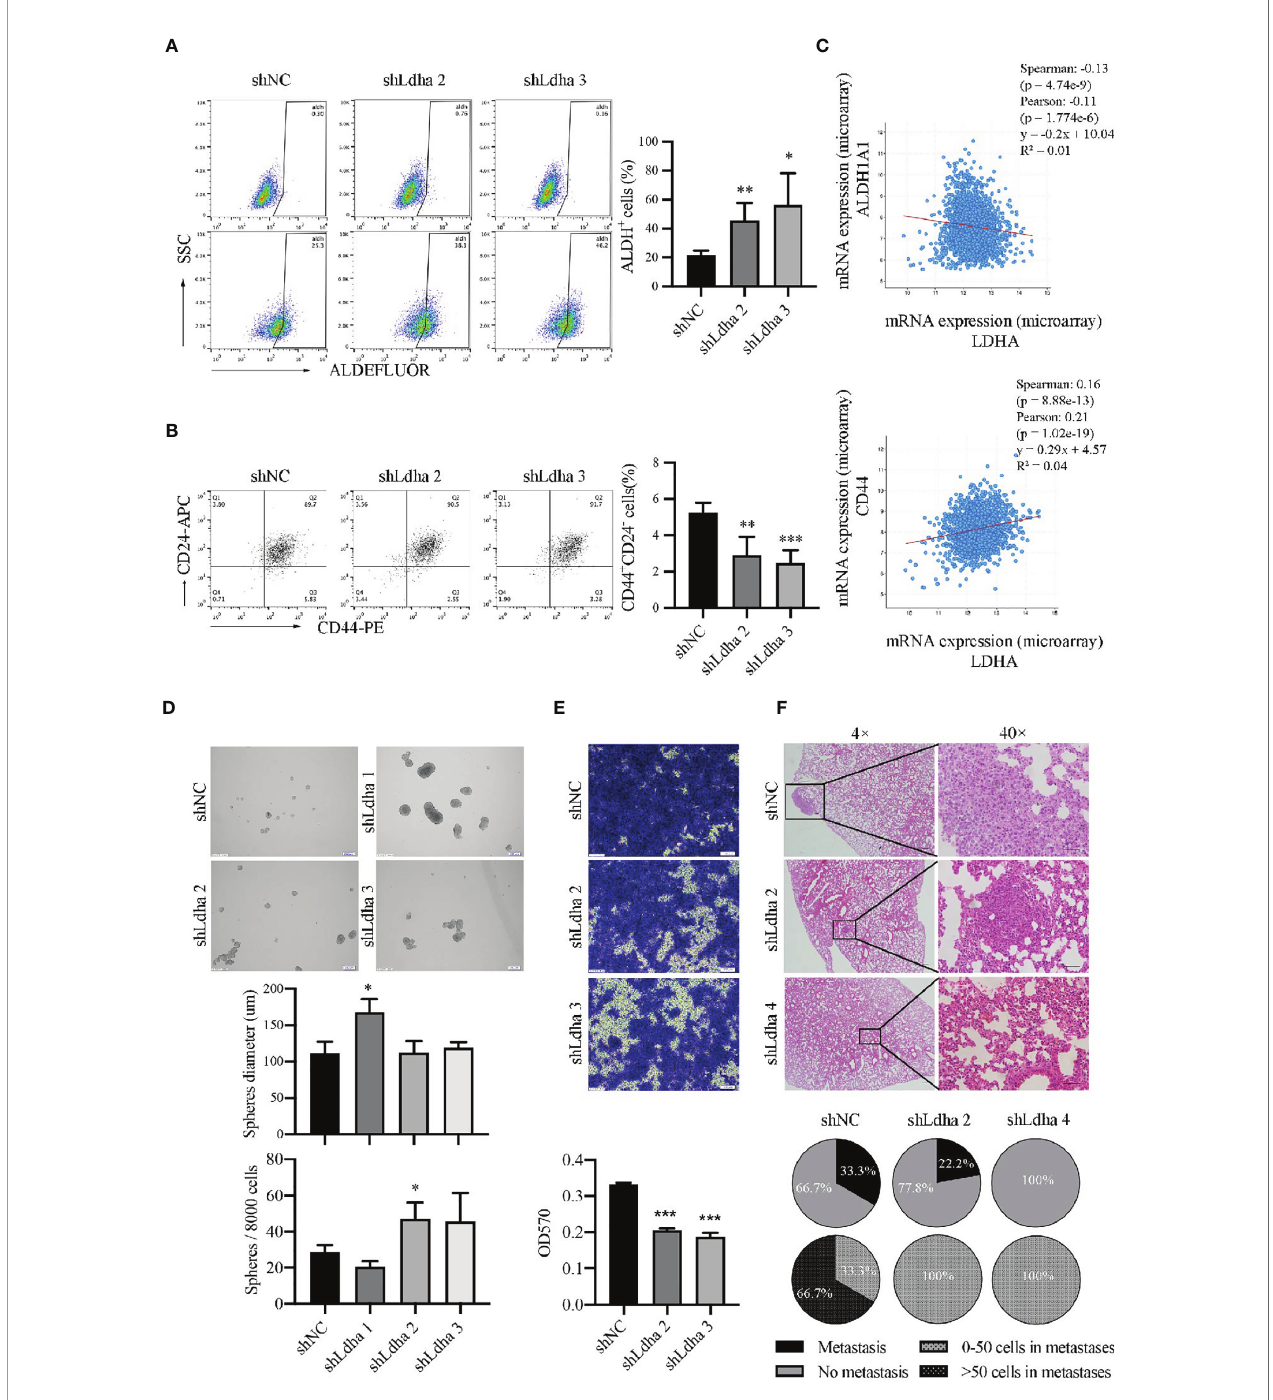
FIGURE 3 | LDHA promoted E to M transition of BCSCs in mouse 4T1 cancer cells. (A) Percentage of ALDH + cells in 4T1- shNC or 4T1-shLdha cells was analyzed by fl ow cytometry. (B) Percentage of CD44 + CD24 − cells in 4T1- shNC or 4T1-shLdha cells was analyzed by fl ow cytometry. (C) Co-expression analysis of LDHA, ALDH1A1 and CD44 by using cBioportal for cancer genomics. (D) 4T1-shLDHA or control cells was cultured in sphere formation medium for 5-7 days, and the diameters and numbers of tumor-spheres were measured under a microscope. Scale bar, 200 m m (insets). (E) Cellular migration of 4T1-shNC or shLdha cells was measured by Transwell assay. Crystal violet was eluted by 33% acetic acid and determined at 570nm. (F) 4T1 shNC or shLdha cells was injected into 4 th breast fat pad of mice and lung was harvested on day 19 after injection. Tumor metastasis was analyzed by hematoxylin-eosin staining. Scale bar, 50 m m (insets). Number of mice with lung metastasis was 3/9(4T1 shNC), 2/9(shLdha 2) and 0/7(shLdha 4). The number of mice with more than 50 tumor cells in metastatic foci was 2/3(4T1 shNC), 0/2(shLdha 2) and 0/0(shLdha 4). * P < 0.05; ** P < 0.01; *** P <